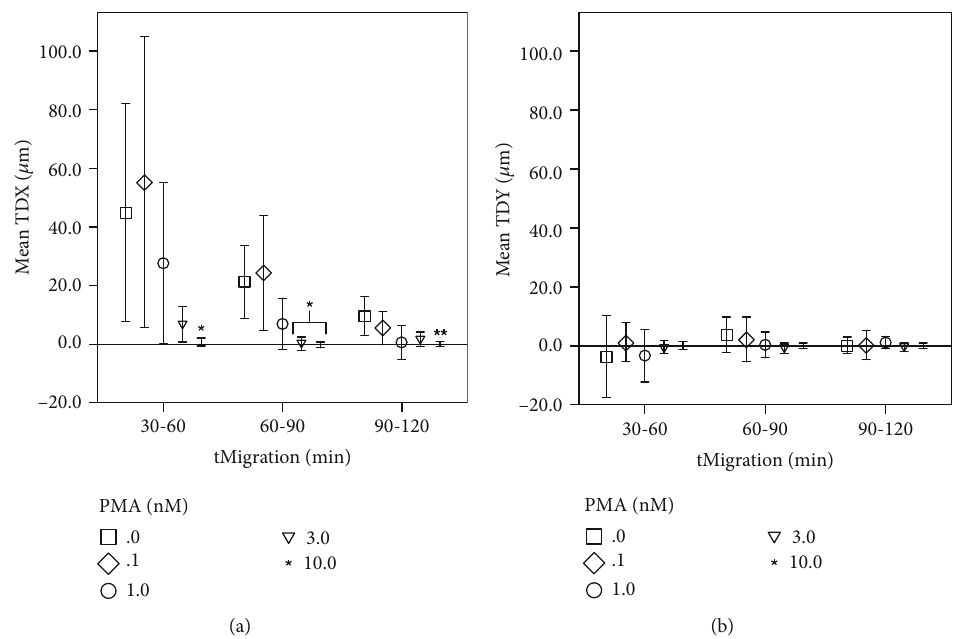
Figure 1: Track displacement decreases during time-lapse and PMA. x -axis: 30-minute time intervals tMigration (min) in minutes, y -axis: (a) mean track displacement along the x -axis TDX in μ m; (b) mean track displacement along the y -axis TDY ( μ m) in μ m; comparing di ff erent PMA concentrations (0 – 10 nM); ∗ signi fi cant when compared to 0 nM and 0.1 nM PMA; ∗∗ signi fi cant when compared to 0 nM PMA; error bars represent standard deviation of measurements.